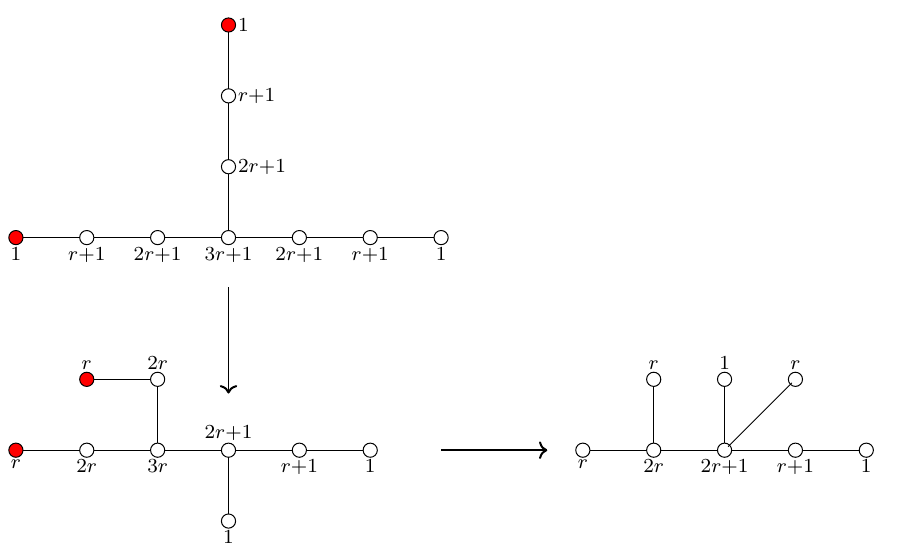
Figure 7. The FI deformations leading from the third quiver in figure 6 to the 3d mirror of the Lagrangian theory